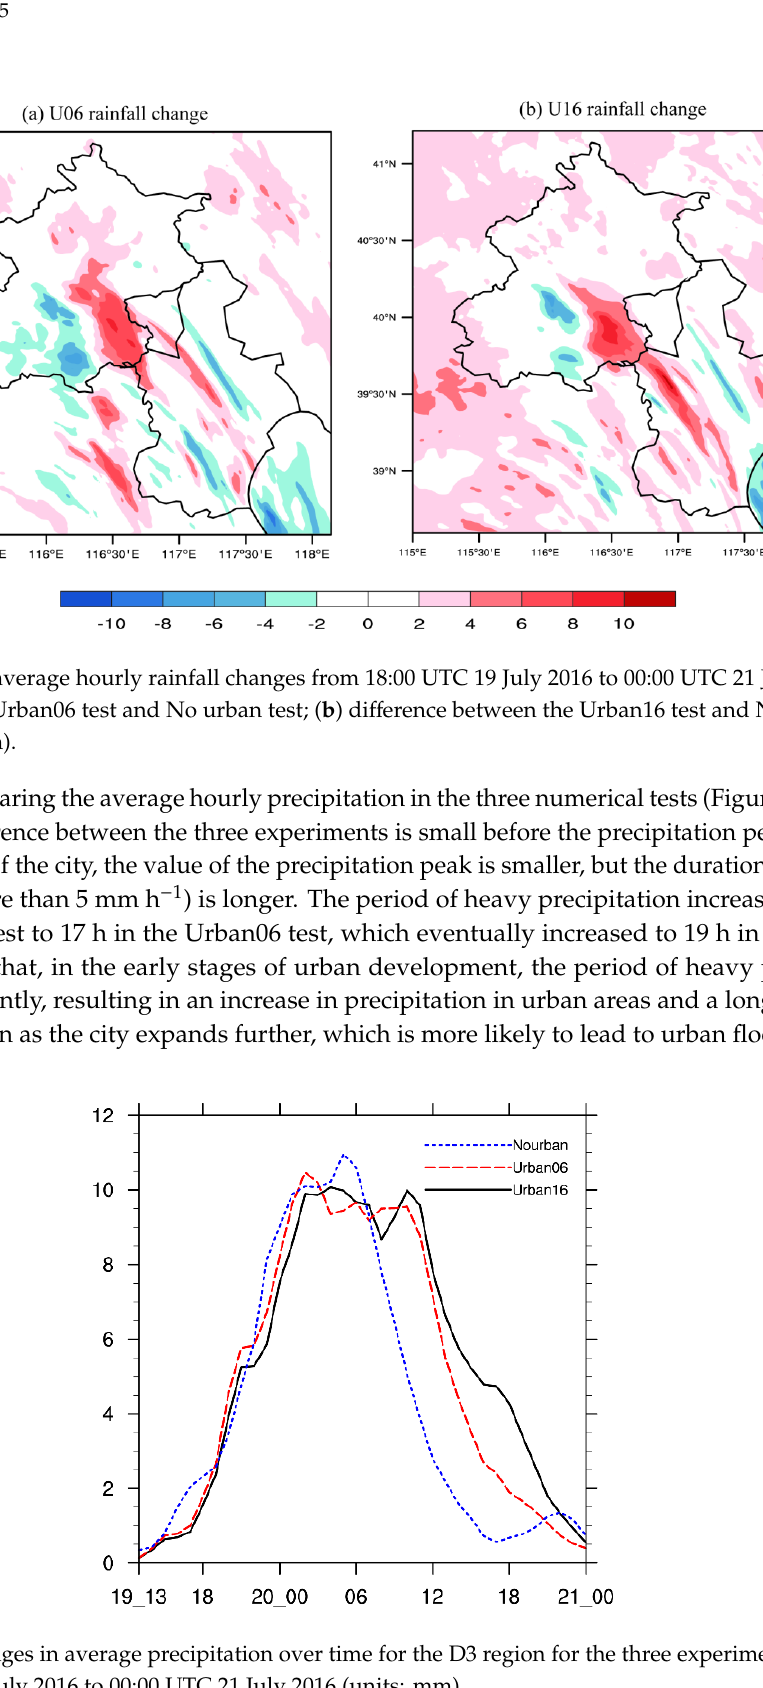
Figure 6. The 22 °C isotherm in the Urban16 test (black line), Urban06 test (blue line), and No urban test (red line): ( a ) 00:00 UTC on 20 July; ( b ) 03:00 UTC on 20 July. The 18 g kg −1 specific humidity line in the Urban16 test (black line), Urban06 test (blue line), and No urban test (red line): ( c ) 22:00 UTC on 19 July; ( d ) 01:00 UTC on 20 July. The purple shading shows the urban area of the Urban16 test.